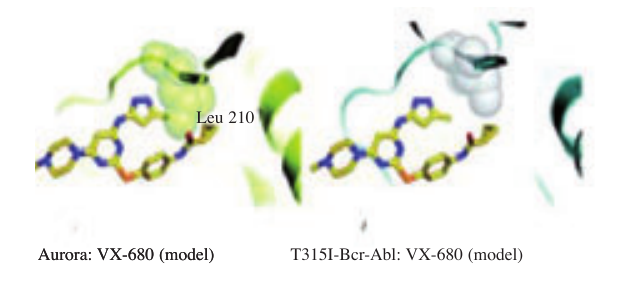
Figure 4. Binding mode of VX-680 to aurora A and T315I-Bcr-Abl. Both leucine 210 and isoleucine 315 side chains can be accommodated between the two arms of the “Y” of VX- 680. [Reprinted and adapted with permission of AACR from: Young MA, et al. Structure of the kinase domain of an imatinib-resistant Abl mutant in complex with the Aurora kinase inhibitor VX-680. Cancer Res 2006 Jan 15;66(2):1007-14].